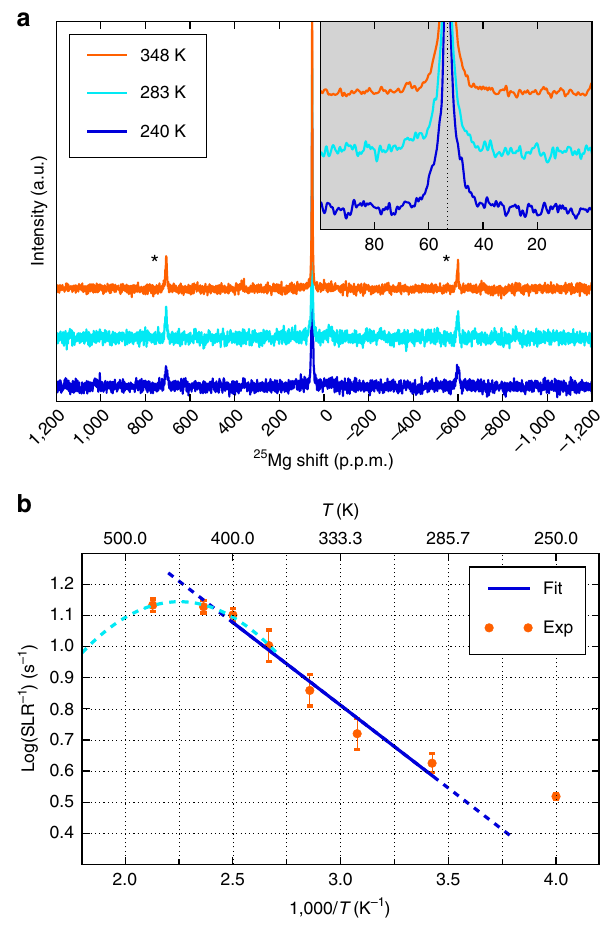
Fig. 3 Characterization of Mg transport in MgSc 2 Se 4 via 25 Mg solid-state NMR. a Stack plot of 25 Mg magic angle spinning (MAS) variable temperature NMR of MgSc 2 Se 4 collected at 11.7 T with a spinning speed of 20 kHz. *Spinning sidebands. b 25 Mg static variable temperature spin lattice relaxation data collected at 7.02 T plotted as function of temperature and Arrhenius fi t (blue line). Dashed dark blue line illustrates the deviation of experimental data from the fi t. The light blue dashed parabolic curve mimics the expected inverse SLR maxima vs. recorded data. The inset of panel a shows the enlargement of the 25 Mg MAS NMR signal at ~ 53